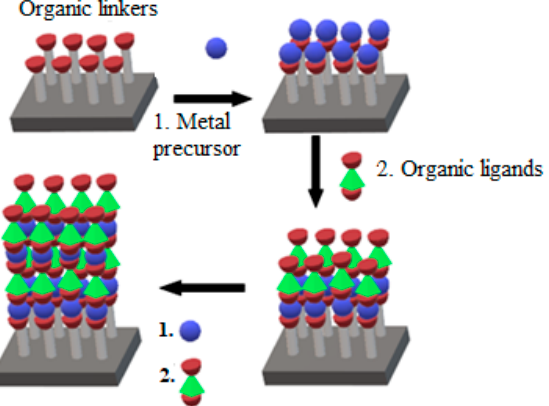
Figure 7. Schematic representation of the LbL deposition method.